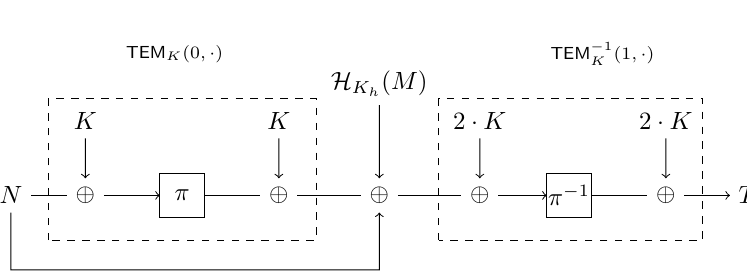
Figure 5: The construction PDM ∗